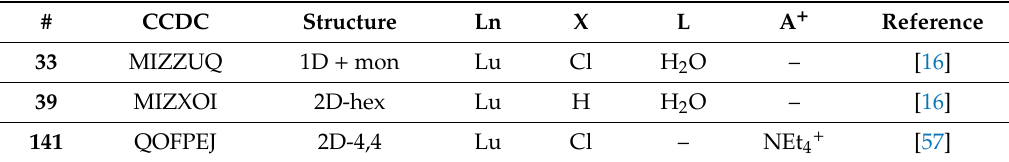
Table 27. Structurally characterized Lu(III) compounds with anilato